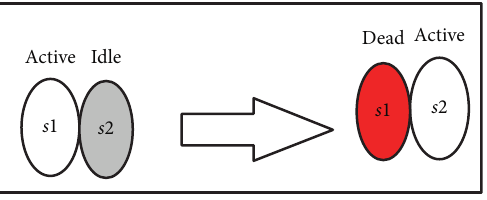
Figure 6: The proposed